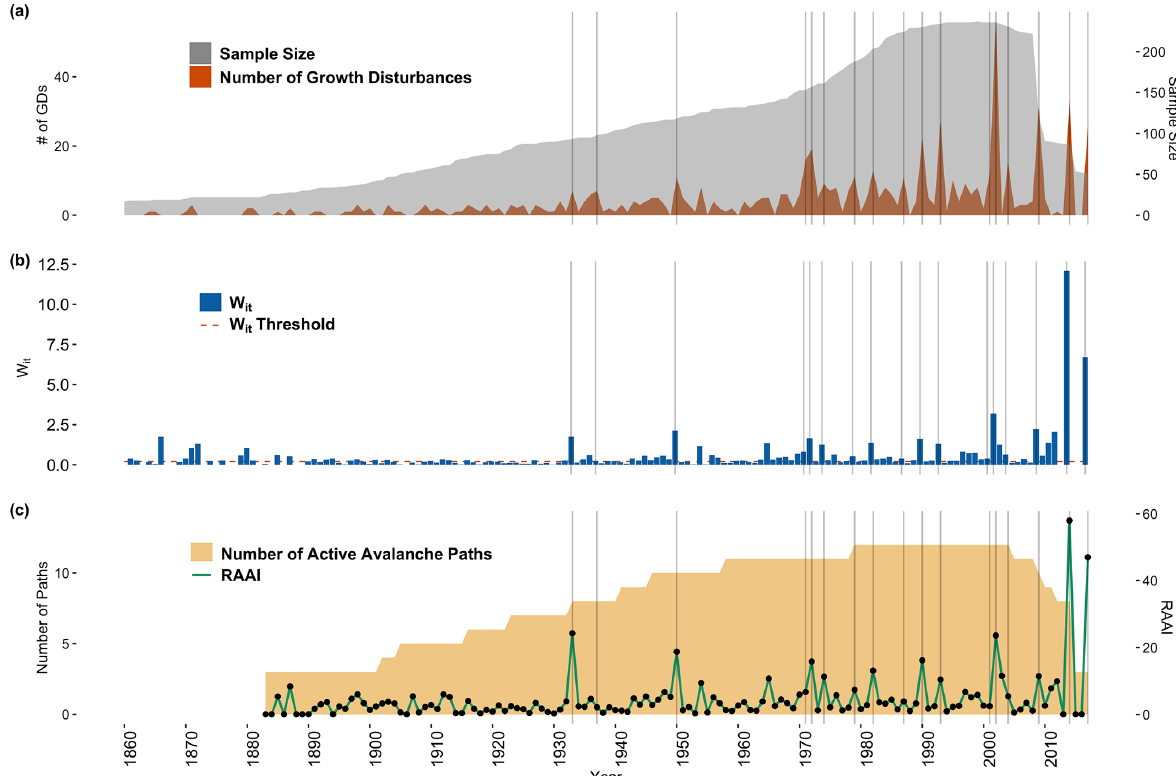
Figure 8. (a) The number of samples (gray shaded area) increases through time, but the number of responses (dark orange shaded area) varies. Note that sample size is on a secondary (right) y axis. (b) The W it , a weighted index factor that accounts for the class of each growth disturbance, threshold (0.2; dashed red line) provides a means of discriminating between high and low confidence signals in the tree-ring record. (c) The regional avalanche activity index (RAAI) (green line, black points) is a measure of regional avalanche activity based on the I t , the ratio of trees exhibiting growth disturbances over the number of samples alive in year t , of each path and the number of active avalanche paths (yellow shaded area). Note RAAI is on a secondary (right) y